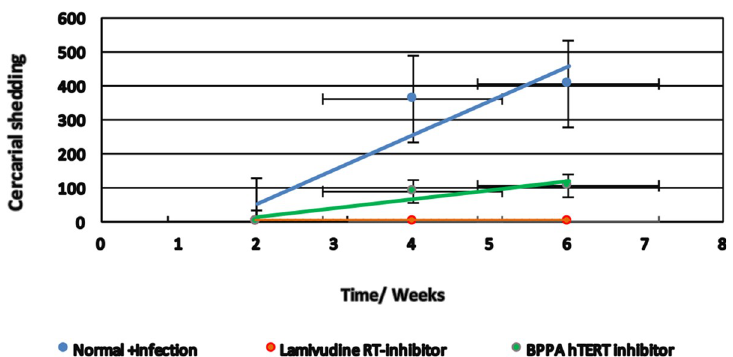
Fig 12. To determine the effect of lamivudine in relation to S . mansoni infection of susceptible BBO2 snails, snails were treated before exposure with 100 ng/ml of the RT inhibitor, maintained at room temperature, and evaluated for up to 6 weeks post-exposure. Note that the BBO2 snails treated before infection with lamivudine failed to shed cercariae at 6 weeks post-exposure to S . mansoni unlike in untreated (control) snails. Also note that BBO2 snails treated with the hTERT RT inhibitor BBPA before exposure, unlike Lamivudine shed cercariae at 6 weeks post- exposure.